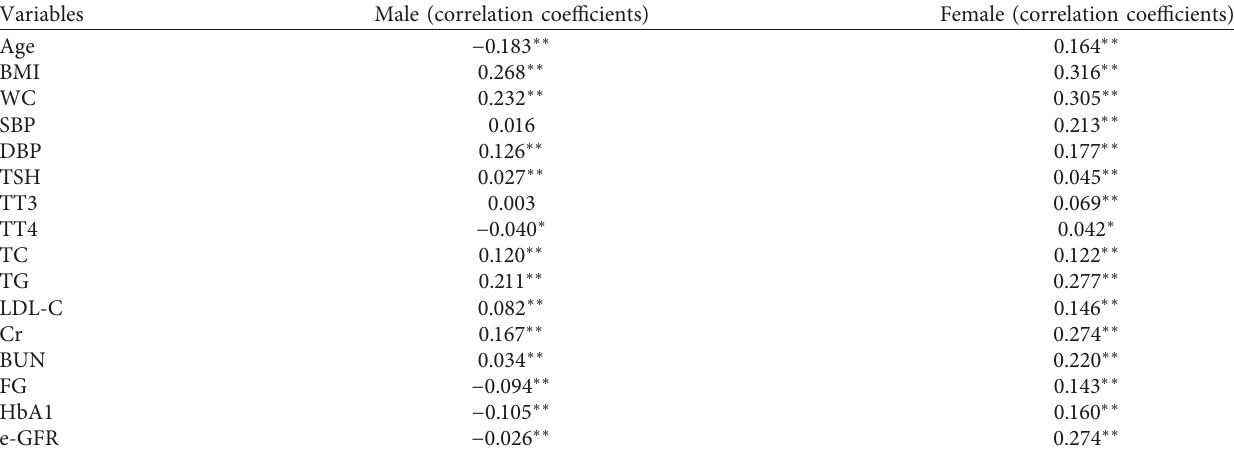
Table 3: Pearson bivariate correlations between UA and other variables.